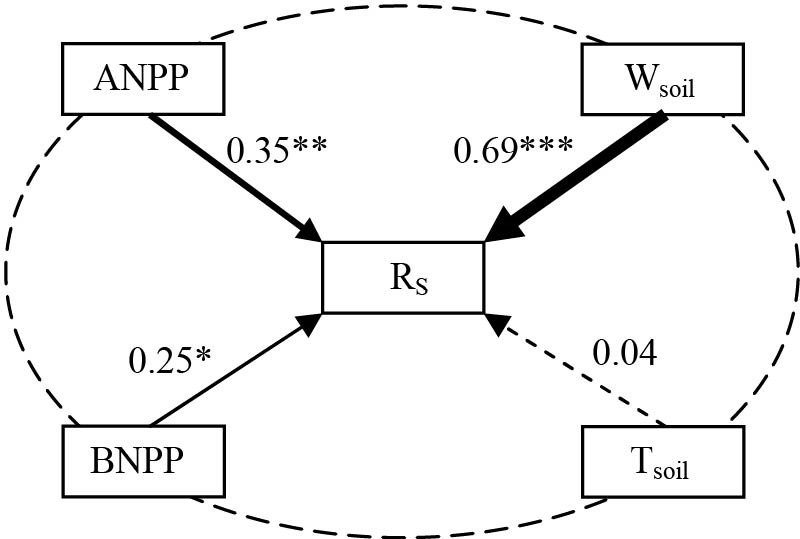
Path analysis on the impacts of land management changes on soil respiration through affecting abiotic and biotic factors.Solid and dashed arrows represent significant (P< 0.05, marked *; P< 0.01, marked **; P < 0.001, marked *** in the figure) and non-significant (P> 0.05) paths. Values associated with arrows represent standardized path coefficients. Tair: soil temperature; Wsoil: soil water content; ANPP: aboveground net primary production; BNPP: belowground net primary production; Rs: soil respiration.